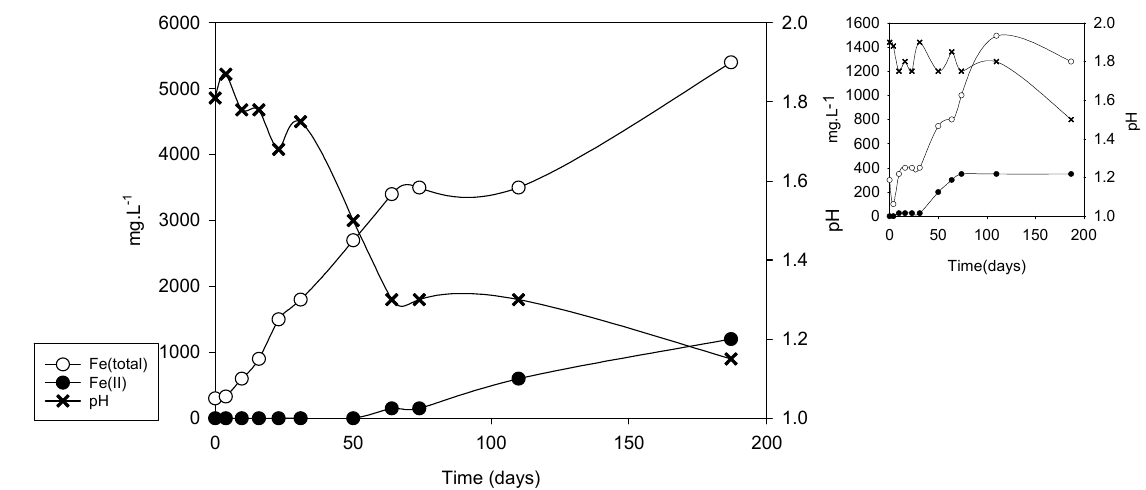
Figure 7. Biooxidation of DC2-5 sample (pulp density: 5 % w/v). Evolution of total soluble iron and ferrous iron concentration, and pH in inoculated (left) and uninoculated (right) systems.